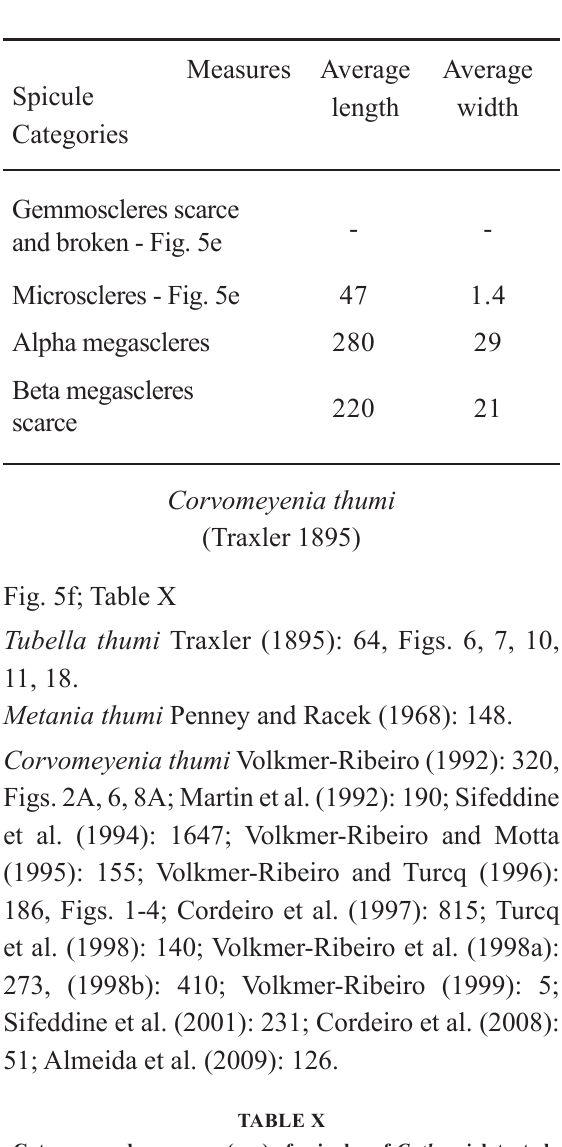
Category and measures (µm) of spicules of C. thumi detected in the studied sections.